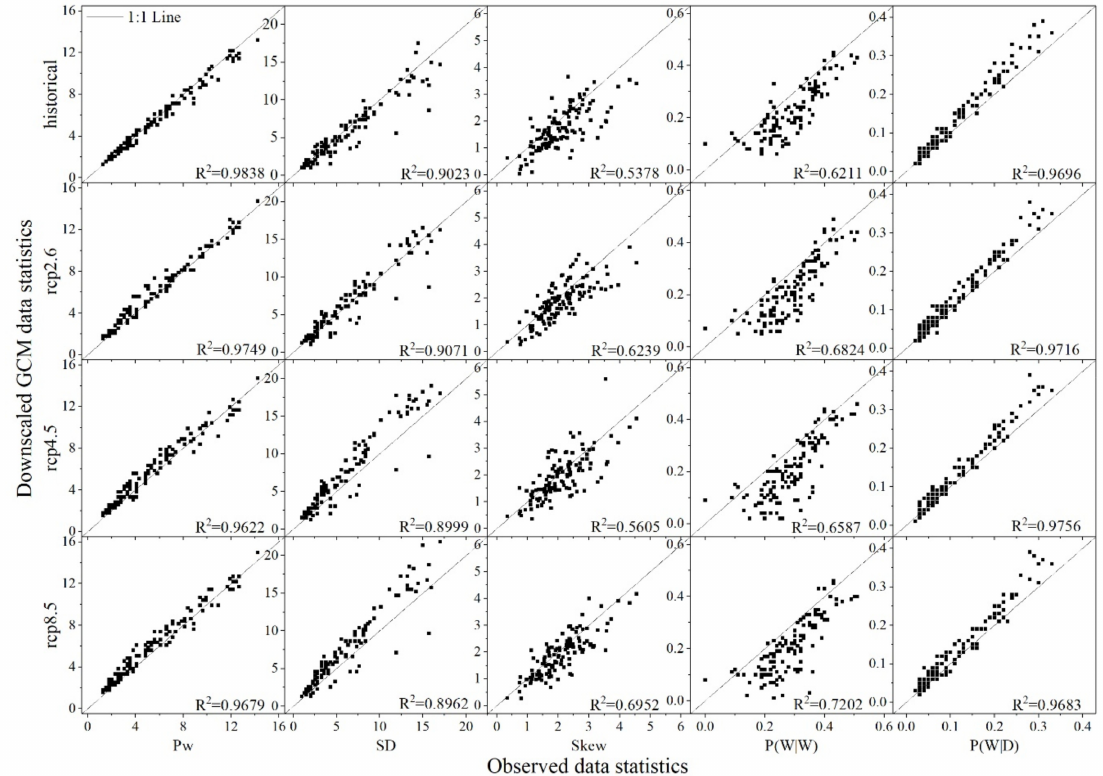
Figure 10. Comparison, in terms of CLIGEN precipitation parameters, between the statistical values of the observed data and the CLIGEN-generated historical single-site data after shu ffl ing (post-shu ffl ed historical data) and the CLIGEN-generated projected single-site data with using shu ffl e procedure (post-shu ffl ed projected data) for ten precipitation stations in the Huangfuchuan Basin. The historical period is 1976–2005. The projection period is 2021–2070. (average daily precipitation on wet days ( Pw ); standard deviation ( SD ) of wet day precipitation; skewness coe ffi cient of wet day precipitation ( skew ); the probability of a wet day following a dry day ( P(W | W) ); the probability of a wet day following a wet day ( P(W | D)